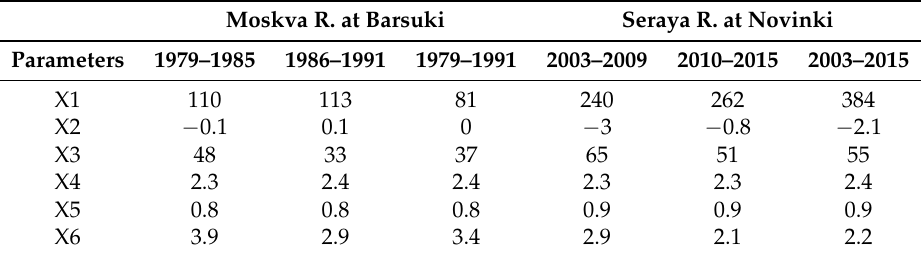
Table 3. Obtained optimal model parameters for different calibration